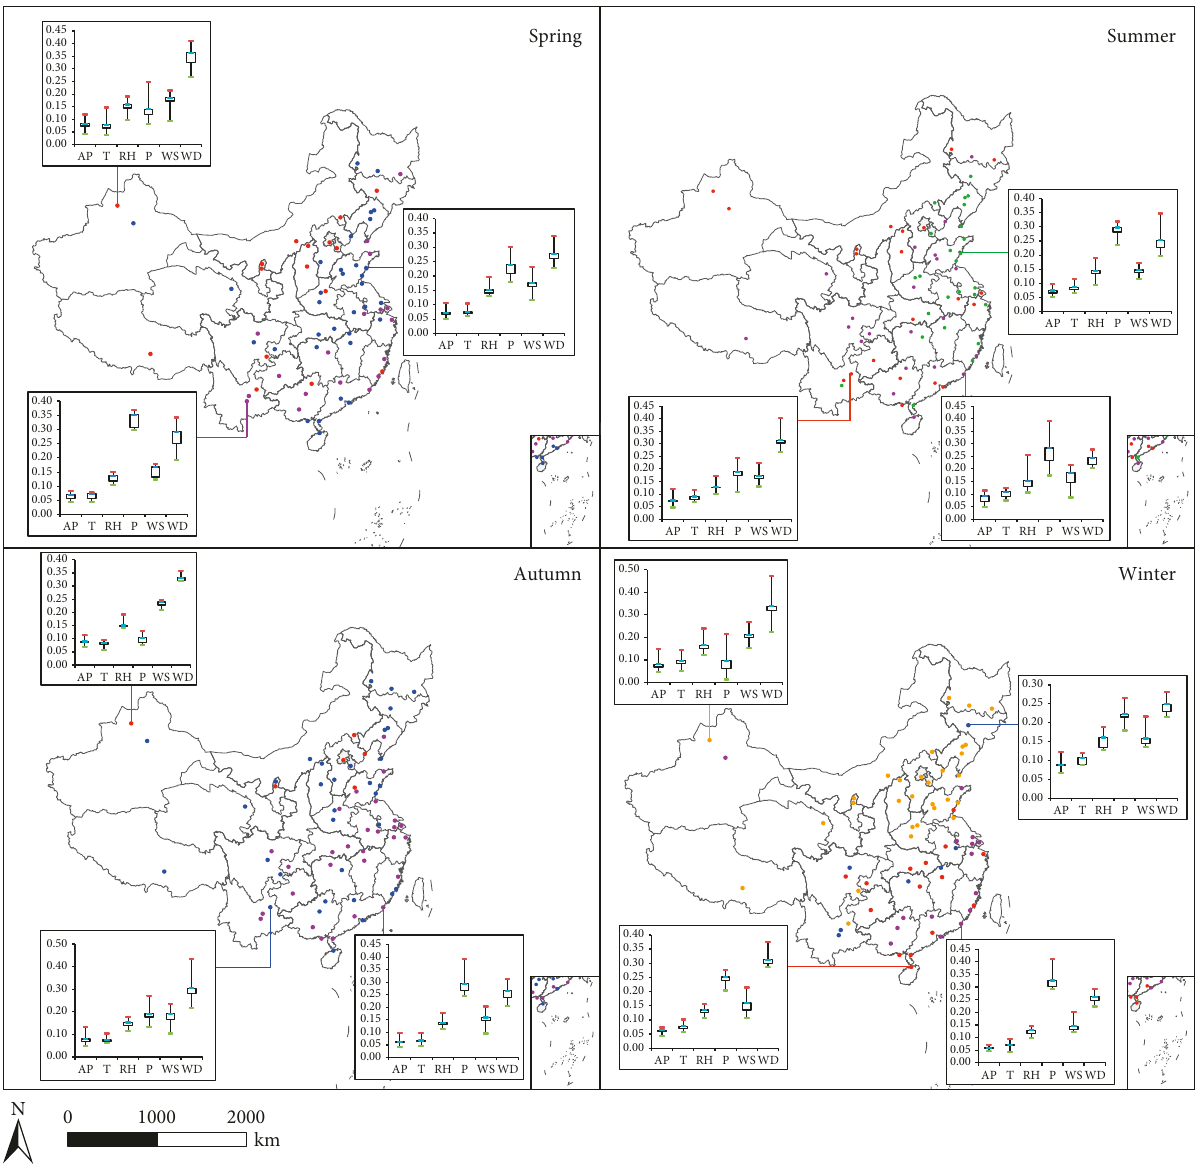
Figure 7: Spatial clustering of the importance of the influence of meteorological factors on the